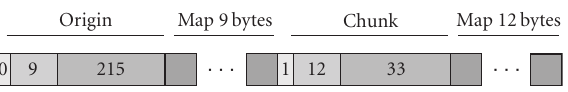
Figure 8: A request